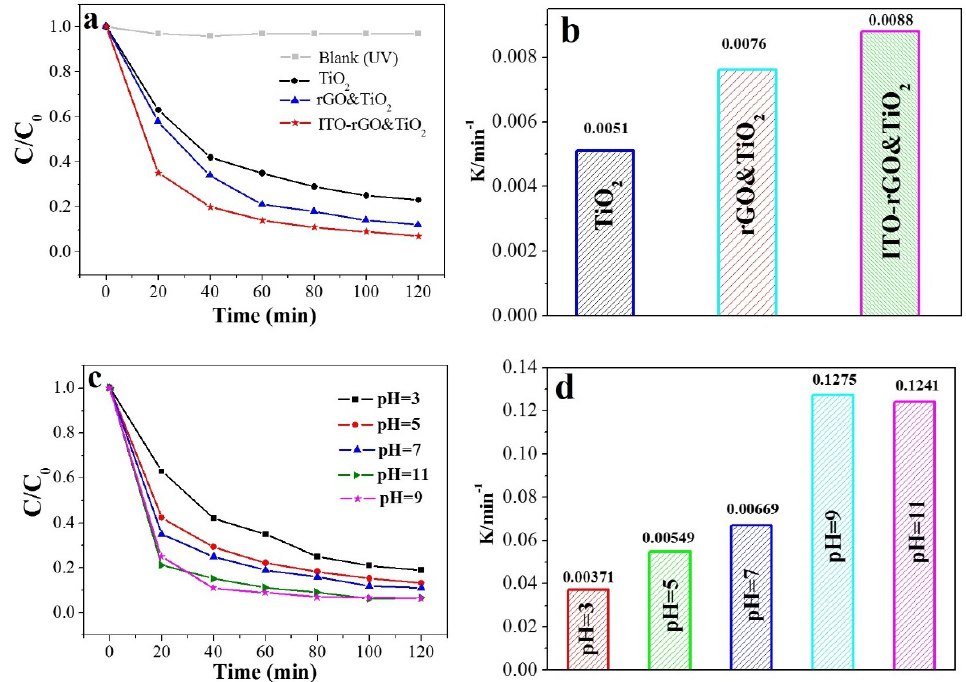
Figure 11. Photocatalytic degradation of MB by pure TiO 2 , rGO and TiO 2 , and ITO-rGO and TiO 2 ( a , c ), and the corresponding first-order rate constant (k) of catalysts in MB decoloring ( b , d ).